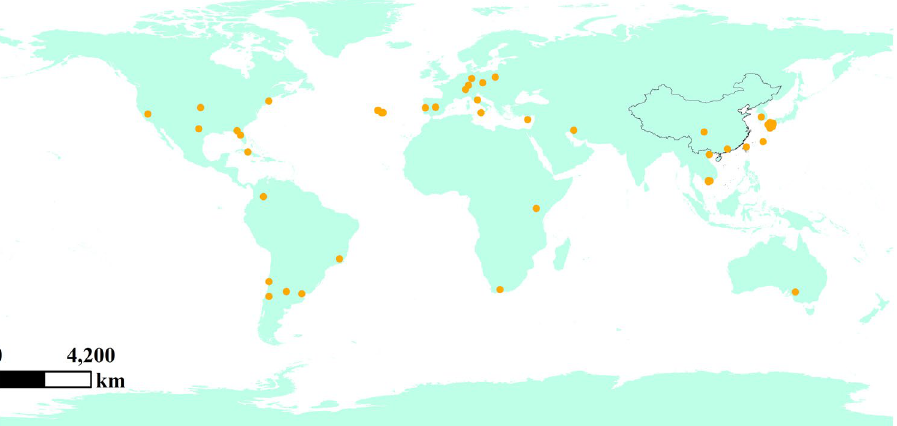
Figure 8. Global distribution of N. californicus . Created in ESRI ArcMap 10.8.1 (https:// suppo rt. esri. com/ en/ Produ cts/ Deskt op/ arcgis- deskt op/